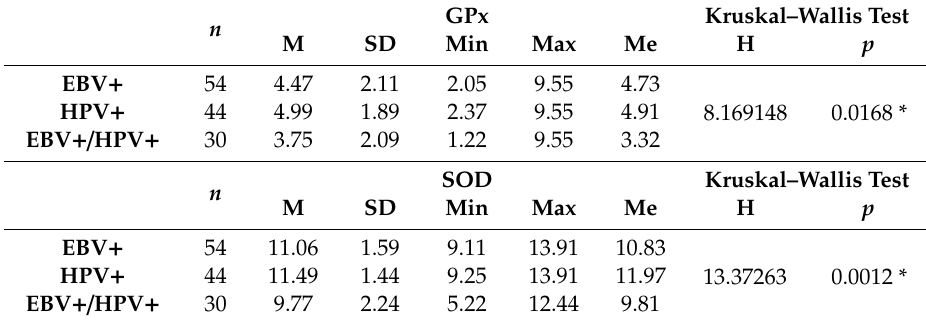
Table 2. Activity of glutathione peroxidase (GPx) (U / mg of protein) and superoxide dismutase (SOD) (U / 100 mg of protein) in tissue of EBV( + ), HPV( + ) and EBV / HPV coinfected patients with oropharyngeal cancer. GPx n